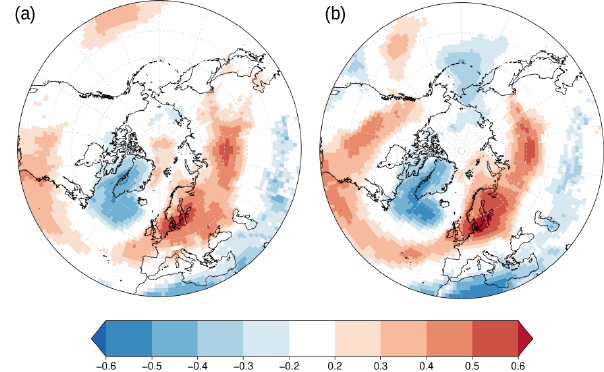
Figure 10. Correlation of ERA5 2m temperature of week 3 with initial NAO index derived from (a) ERA5 or (b) NOAA. Only val- ues significantly different from zero at the 99% confidence level are